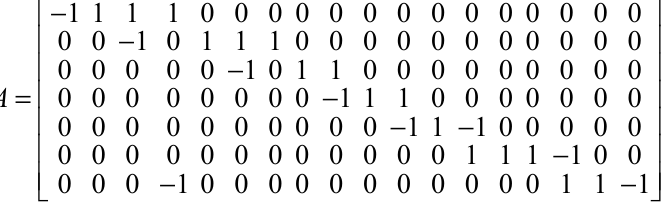
Figure 9. Directed graph of the DN.